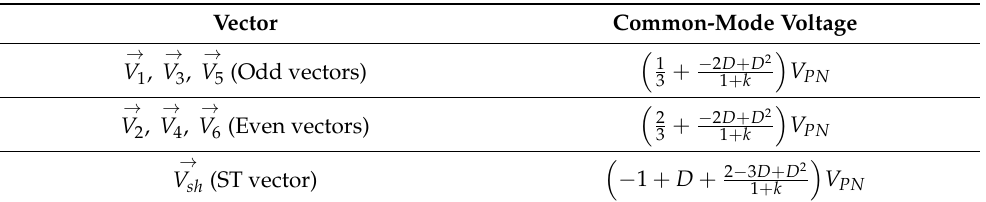
Table 2. CMV values for MAqZSI with proposed CMV-SVM reduction method. Vector